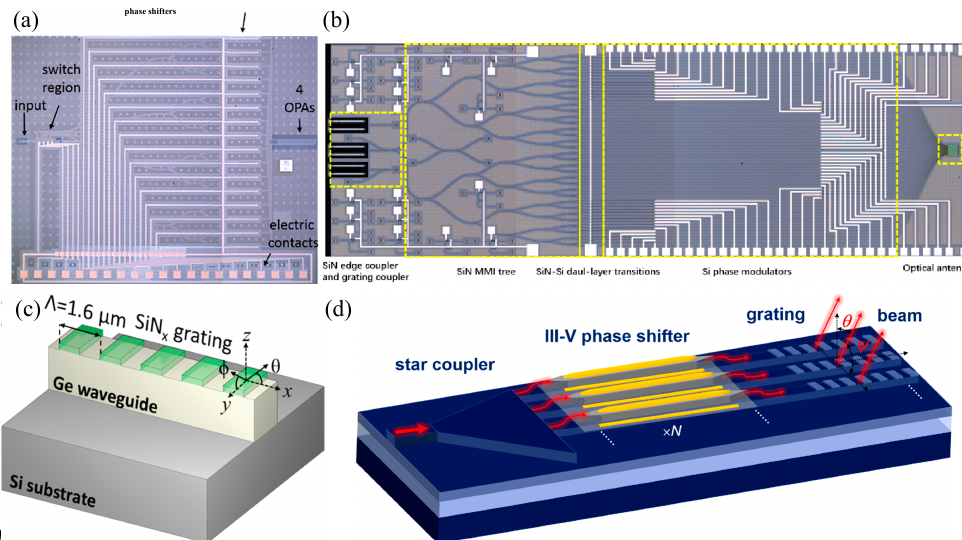
Figure 11. OPAs based on non-Si platforms. ( a ) Microscope image of a Si 3 N 4 OPA for 2D beam steering at a fixed wavelength of 905 nm. Reprinted with permission from [62] © The Optical Society. ( b ) A Si/Si 3 N 4 dual-layer OPA. Reprinted with permission from [88] © 2020 Chinese Laser Press. ( c ) A Si 3 N 4 /Ge-on-Si WGA for MIR OPAs. Reproduced from [72] published by IEEE, 2019. ( d ) A III-V/Si OPA. Reprinted with permission from [126] © The Optical